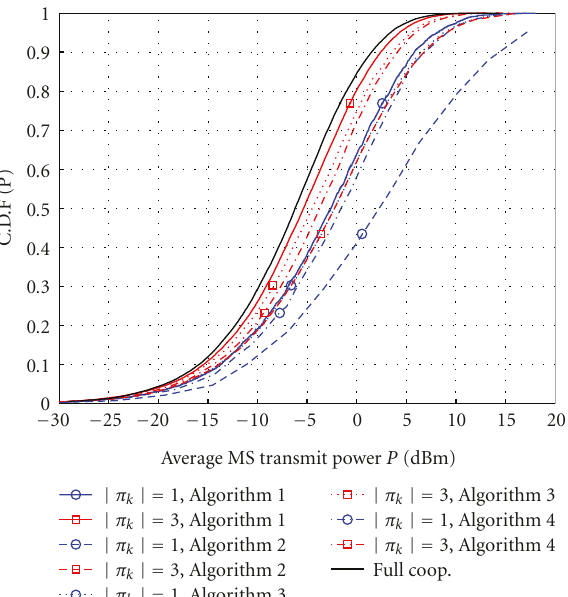
Figure 5: Comparison of CDFs of transmit power of di ff erent sizes of joint processing MBS with the SINR constraint of 8dB.